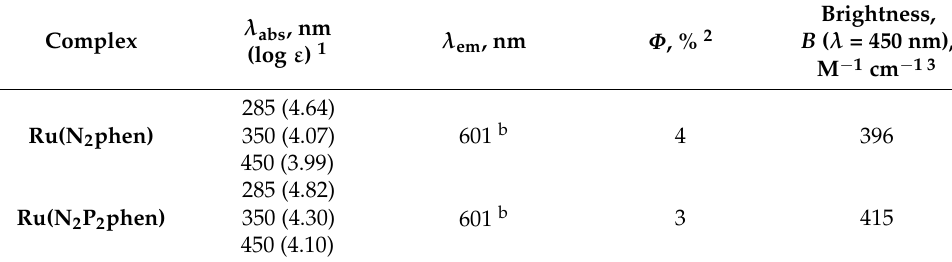
Table 2. Photophysical data for Ru(N 2 phen) and Ru(N 2 P 2 phen). λ abs , nm Complex λ em , nm Φ , % 2 (log ε ) 1